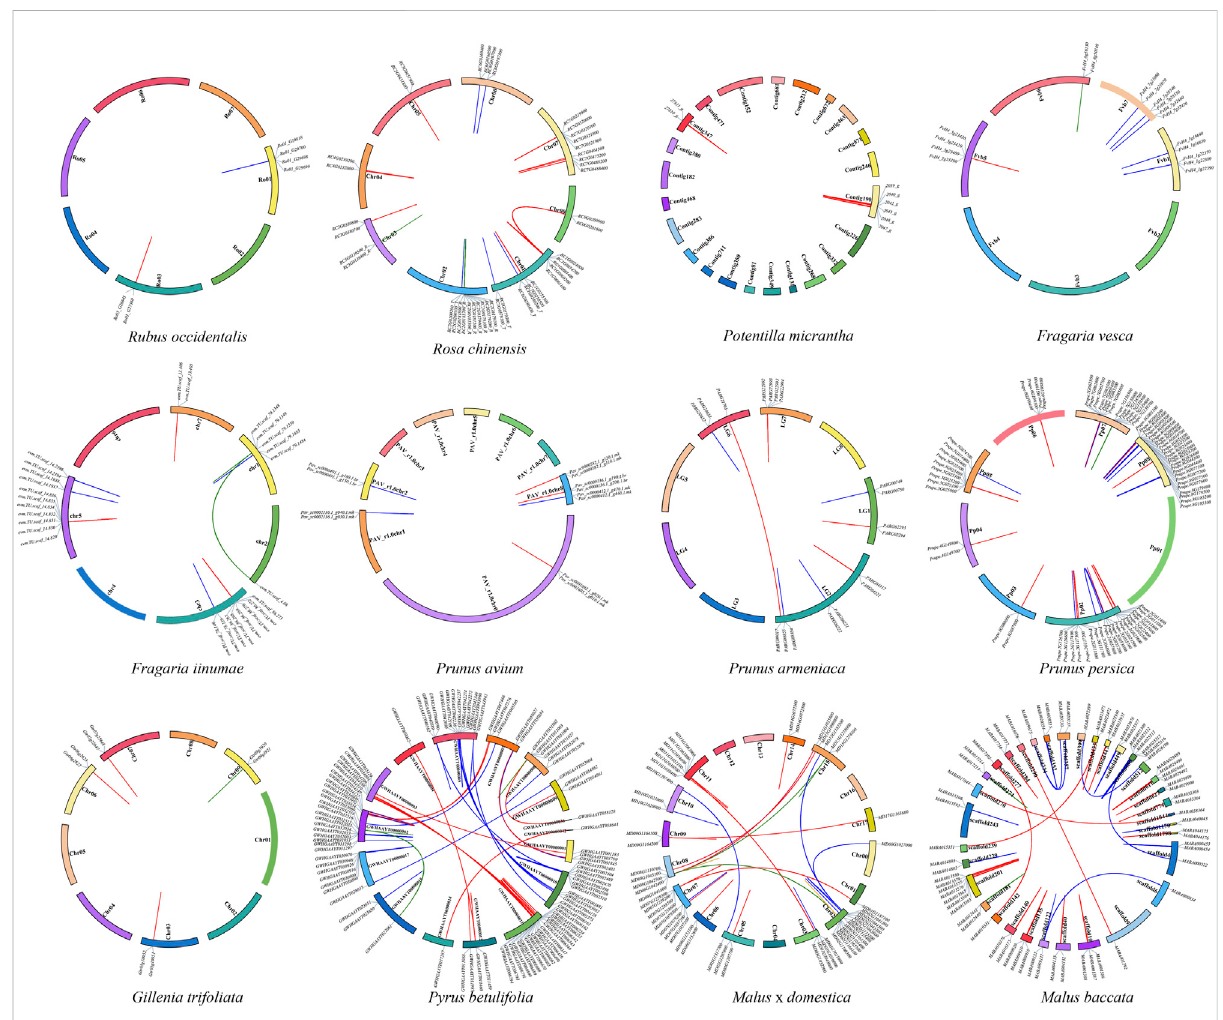
FIGURE 5 Localization and synteny of NBS-LRR genes in Rosaceae genomes. NBS-LRR genes in 12 Rosaceae species were mapped to different chromosomes/contigs/scaffolds. Gene pairs of RNLs , TNLs , and CNLs with a syntenic relationship are connected with green, blue and red lines,